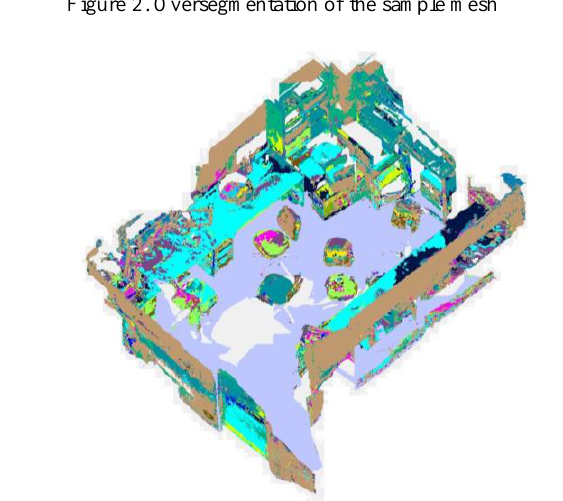
Figure 3. Random Forest classification results (without